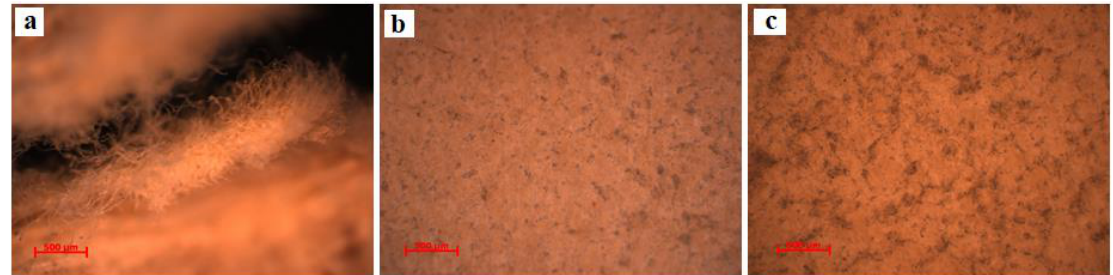
Figure 4. OM images (×50) of document S2: ( a ) the degraded and fringed area on the front; ( b ) well preserved area on the front; and ( c ) well preserved area on the back.